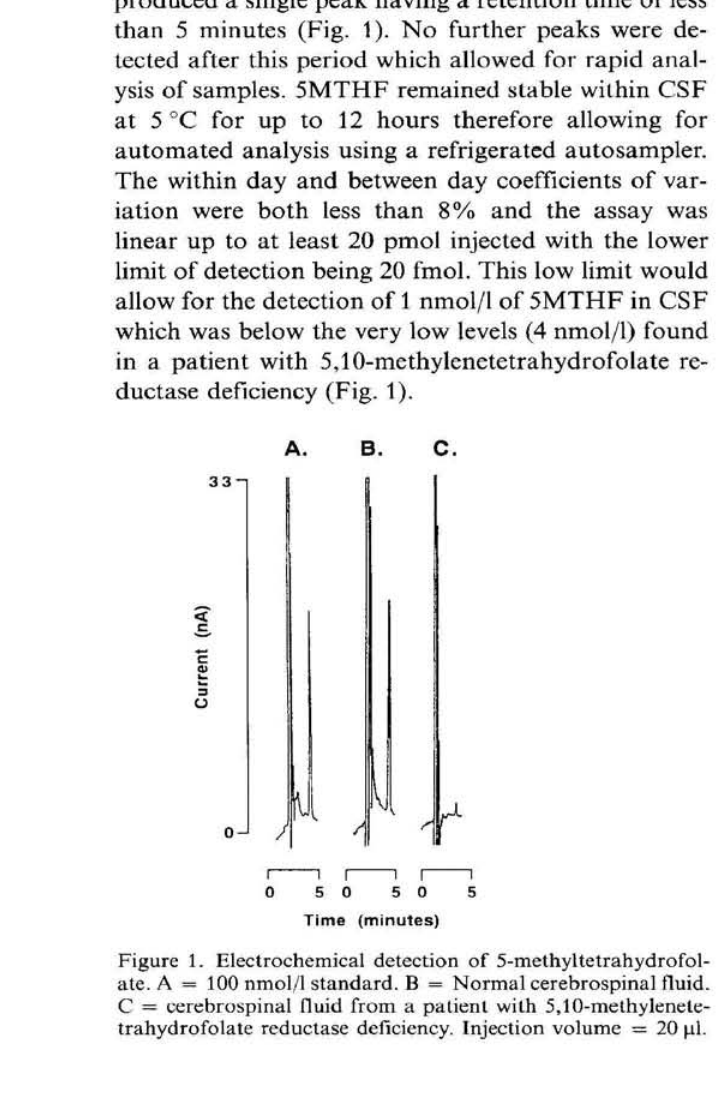
Hydrodynamic voltamograms obtained from the standard and CSF were essentially identical (not